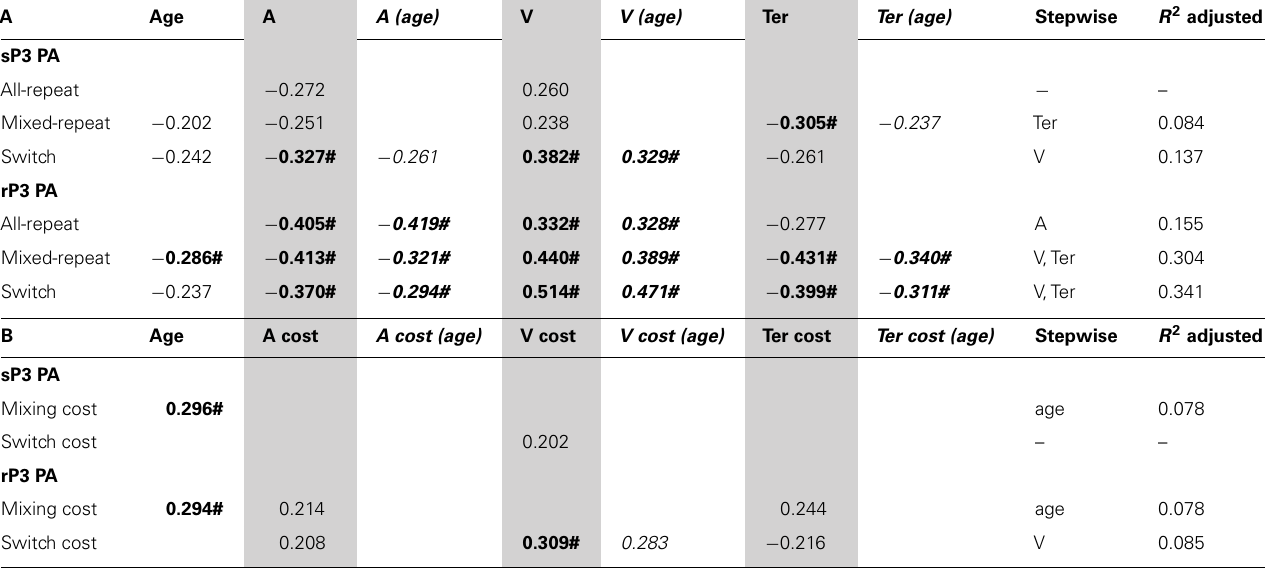
Table 3 | Correlation between peak amplitude of stimulus-/response-locked P3 and age/model parameters for (A) each trial type and (B) mixing/switch cost on both ERP and model